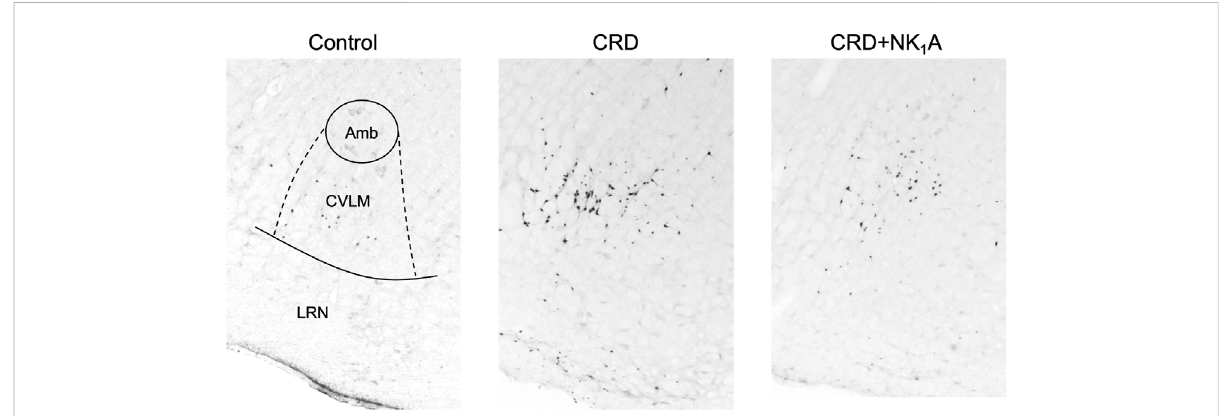
FIGURE 4 Representative vibratome sections through the caudal ventrolateral medulla (CVLM) from the groups stimulated by colorectal distension (Group CRD and CRD + NK 1 A) and non-stimulated (Control) rats. Group CRD received saline, and Group CRD + NK1A received fosaprepitant (30 mg/kg) intraperitoneally before the stimulation. The number of c-Fos immunoreactive cells in the CVLM in Group CRD was higher than in the Control group and Group CRD + NK 1 A. Amb: the nucleus ambiguus. LRN: the lateral reticular nucleus.